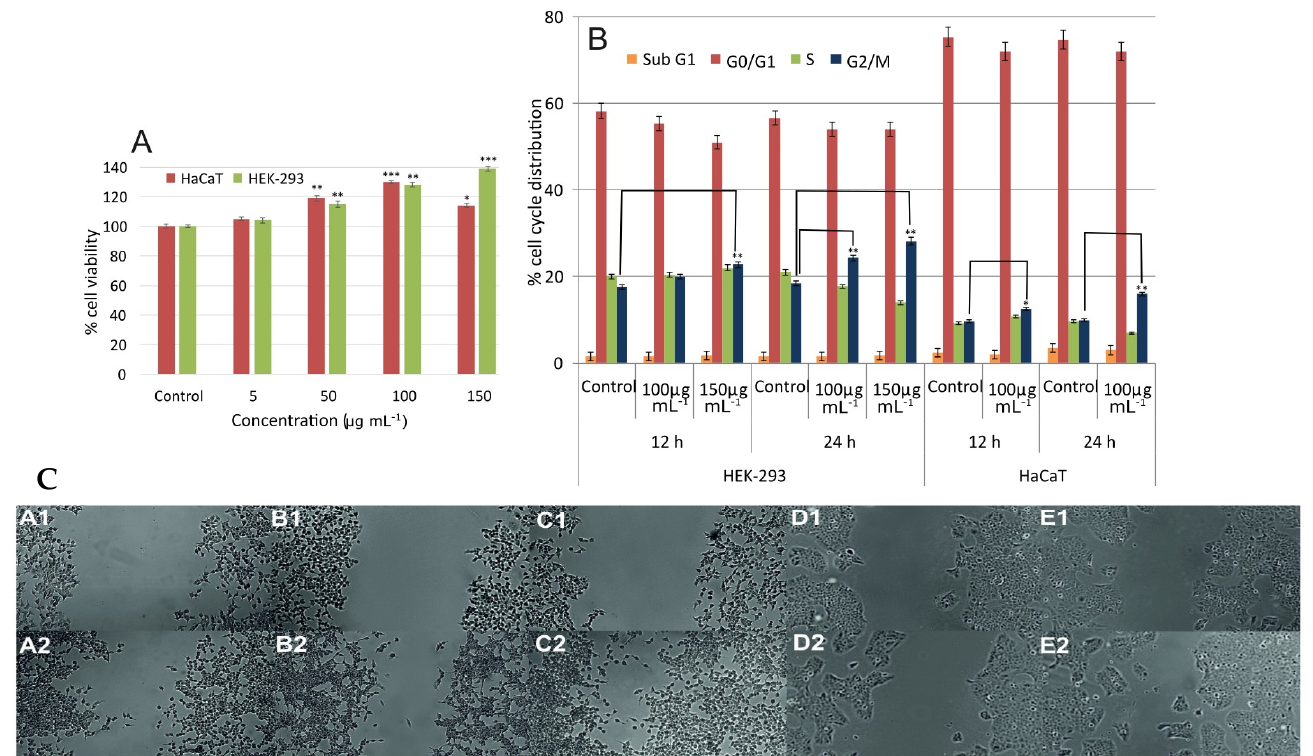
Figure 2. ( A ) Effect of different concentrations of the extract on the cell viability of HEK-293 and HaCaT cells, after 24 h of incubation (statistically significant differences for p < 0.05, p < 0.01, and p < 0.001 are denoted with *, **, and ***, respectively); ( B ): % cell cycle distribution of HEK-293 and HaCaT cells treated with 100 and 150 µ g mL − 1 of the extract after 12 and 24 h; ( C ) scratch assay photos of HEK-293 cells (A1: control 0 h, A2: control 24 h, B1: treated with 100 µ g mL − 1 at 0 h, B2: treated with 100 µ g mL − 1 at 24 h, C1: treated with 150 µ g mL − 1 at 0 h, and C2: treated with 150 µ g mL − 1 at 24 h) and HaCaT cells (D1: control 0 h, D2: control 24 h, E1: treated with 100 μ g mL − 1 at 0 h, and E2: treated with 100 μ g mL − 1 at 24 h).